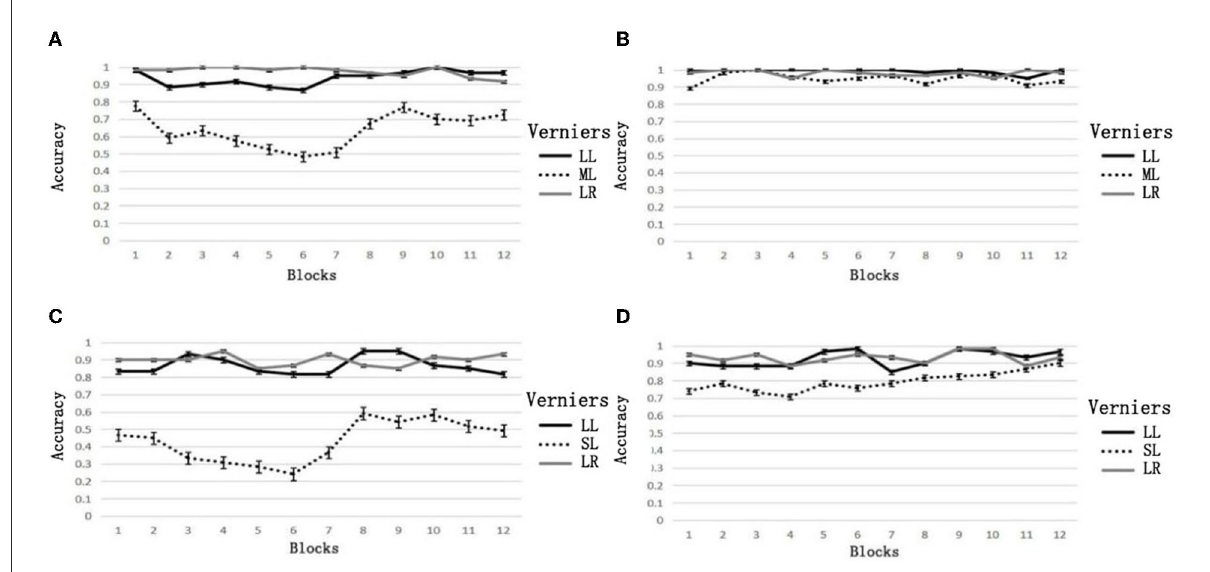
FIGURE2 Accuracy of trial feedback. (A) Medium, biased feedback, (B) medium, consistent feedback, (C) small, biased feedback, (D) small, consistent feedback.